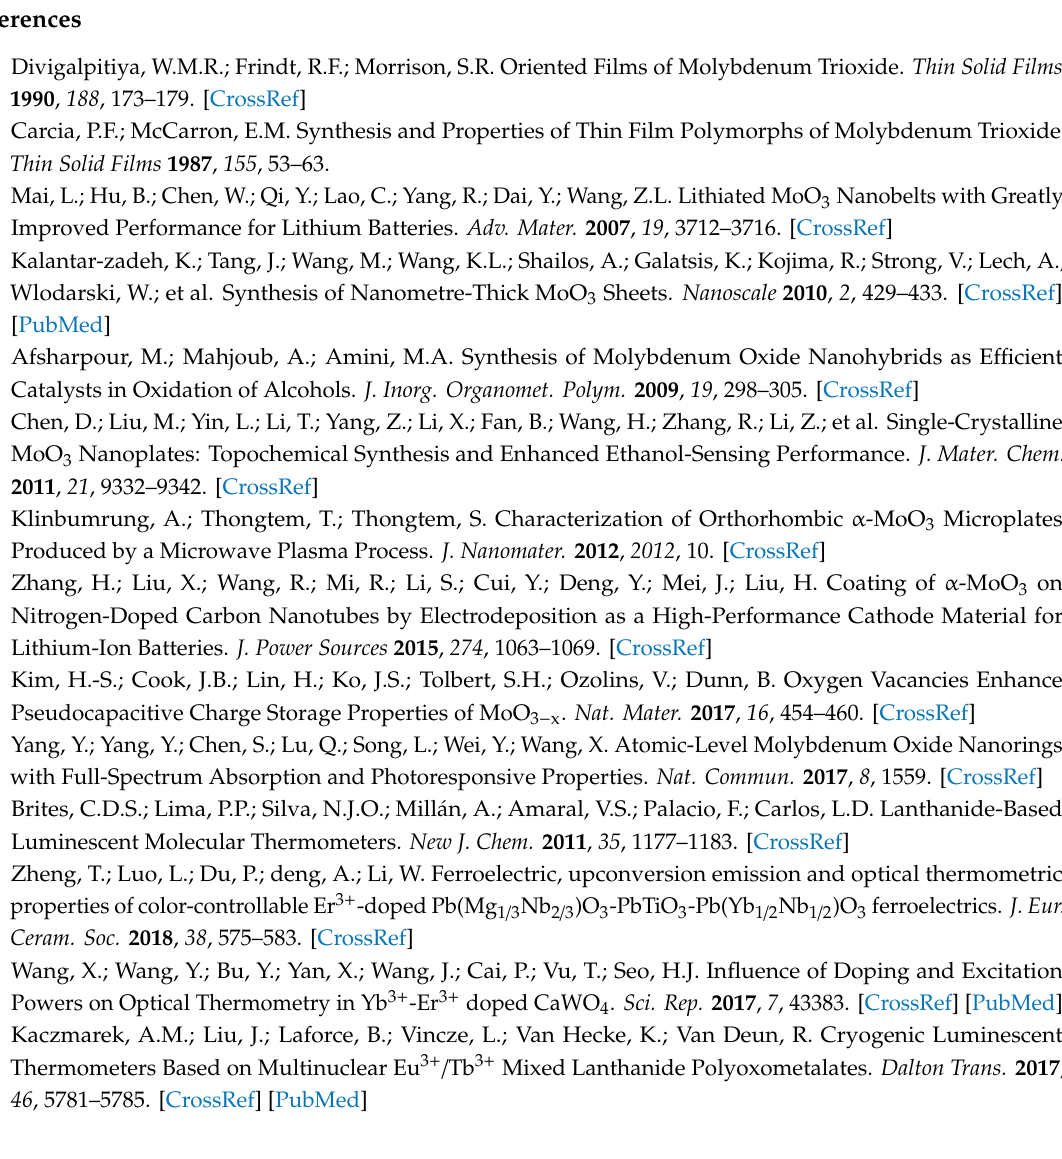
Table S3. Assignment of labeled transition peaks shown in Figure S7, Table S4. Assignment of labeled transition nm, Table S6. CIE colour coordinates (x, y) of α -MoO 3 :0.5% Eu 3 + , 4.5% Tb 3 + calculated at di ff erent temperatures, Table S7. CIE colour coordinates (x, y) of α -MoO 3 :1% Er 3 + , 10% Yb 3 + calculated at di ff erent